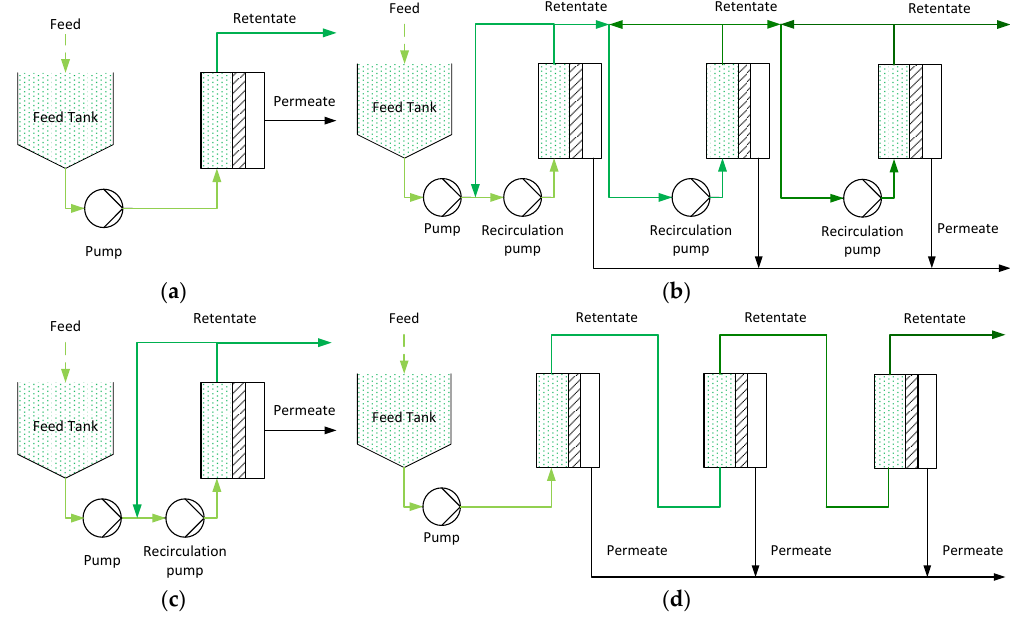
Figure 1. Concepts in literature for ultrafiltration ( a ) Feed and Bleed ( b ) Multistep Feed and Bleed ( c ) Single Pass Tangential Flow (SPTFF) ( d ) Multistep SPTFF [33,34].